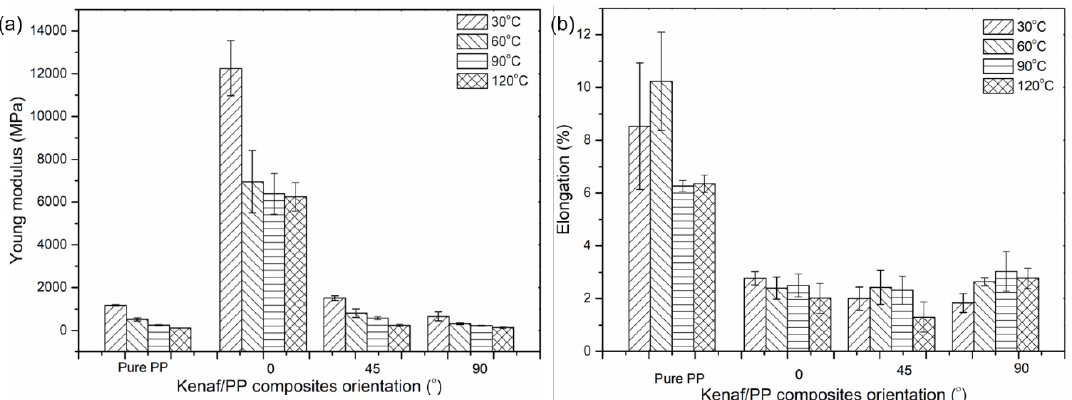
Figure 3. ( a ) Young’s modulus and ( b ) elongation of kenaf/polypropylene (PP) composites at different orientation angles and temperatures.